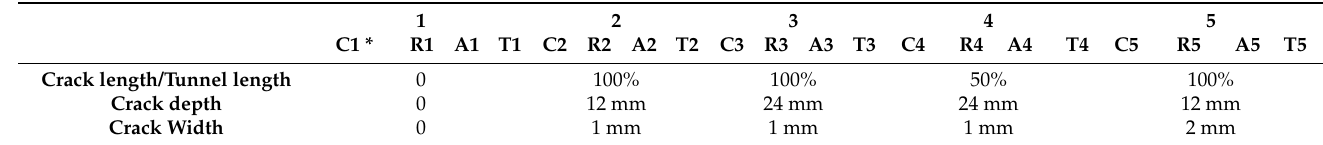
Table 1. Groups of cracked cable tunnel modelling.